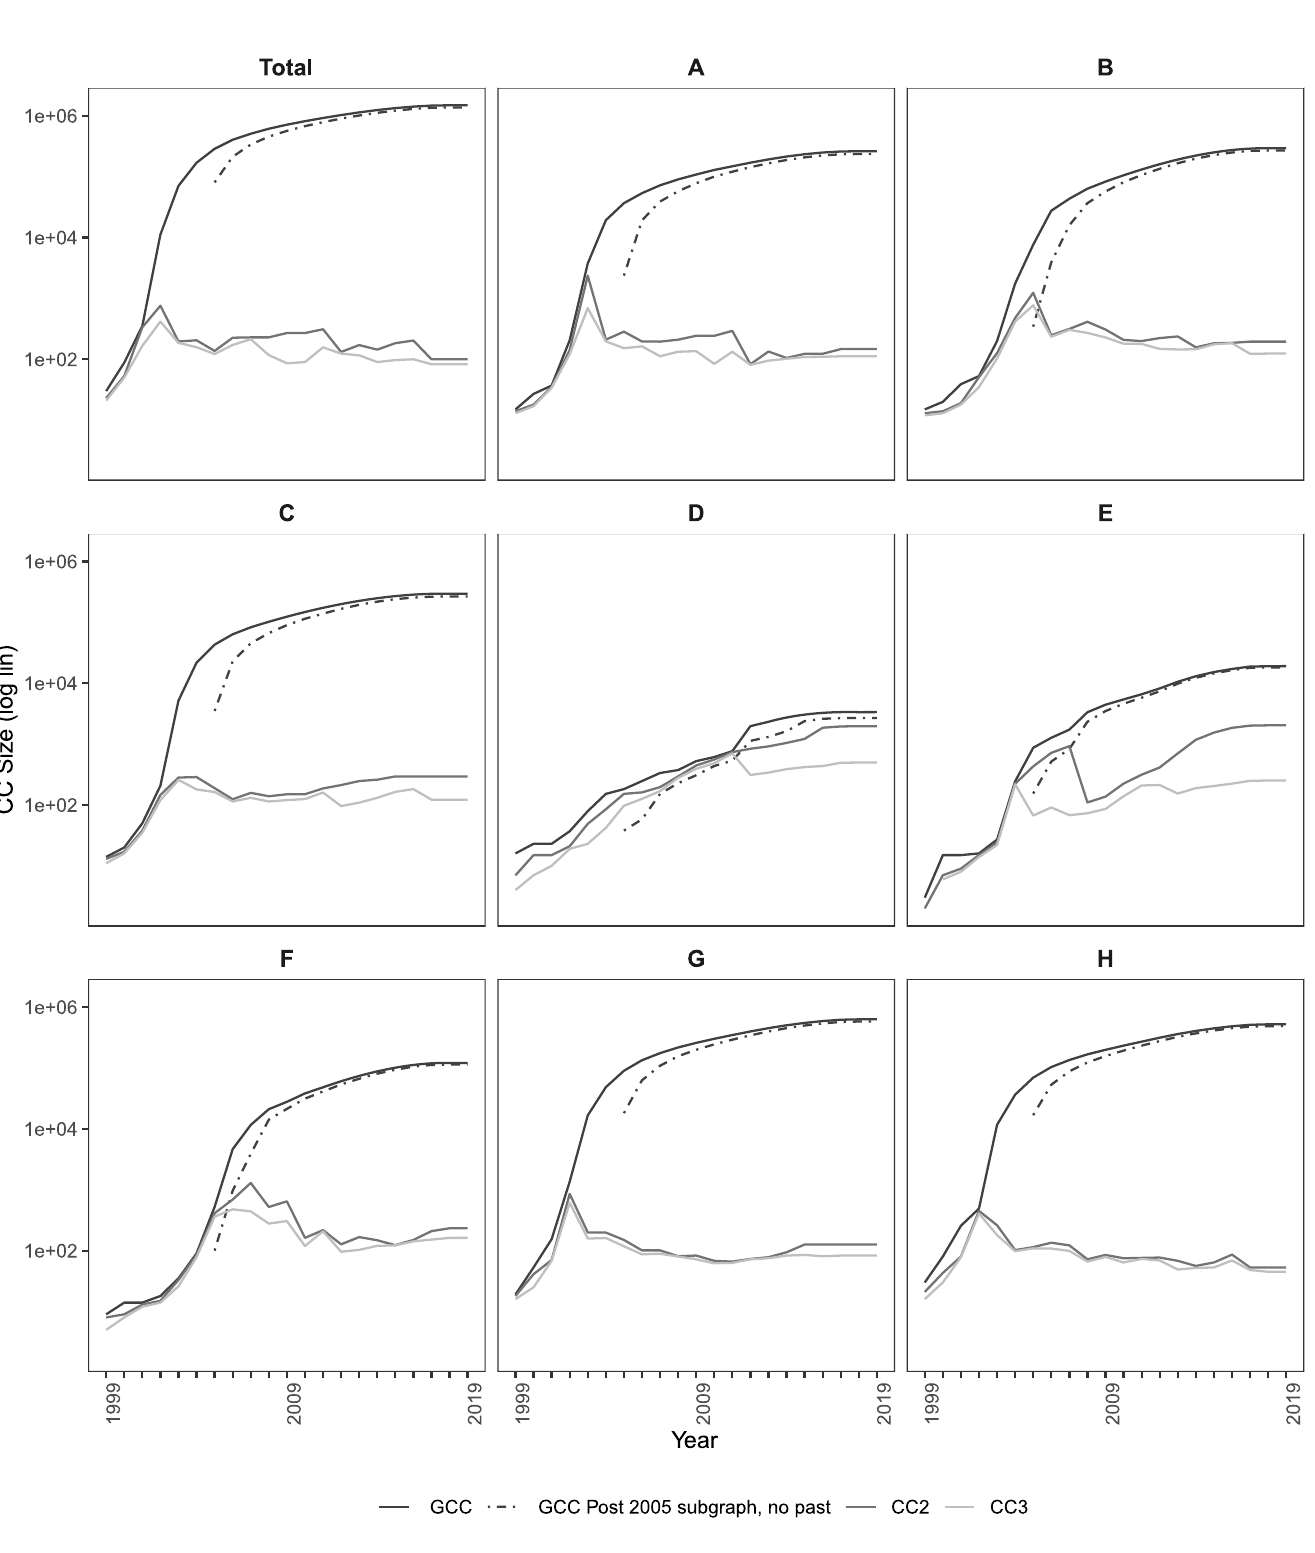
Fig 6. The giant, 2nd and 3rd component size (in log) over time by technological field, 1999–2019.